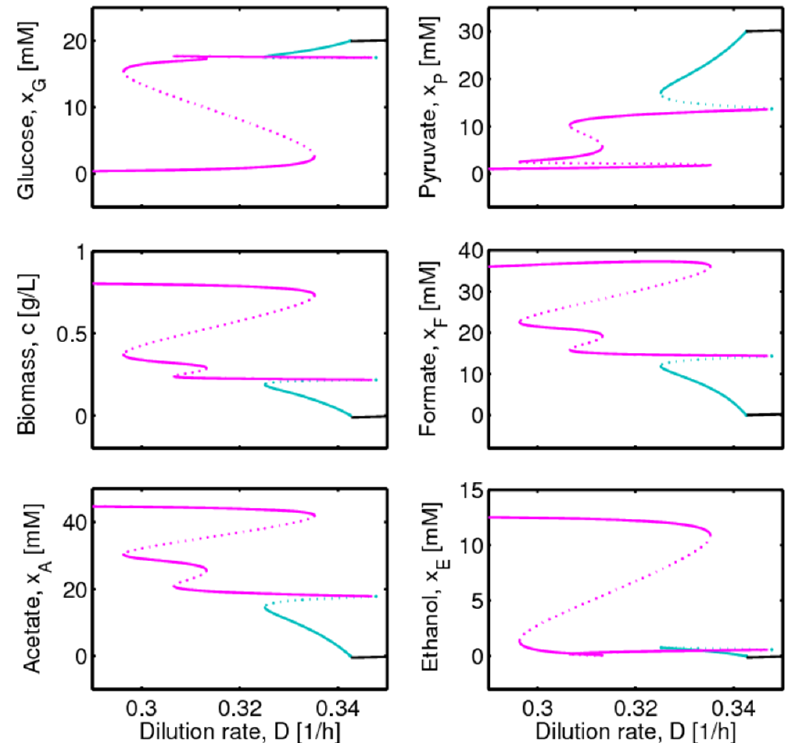
Figure 5. Hysteresis curves of all components when γ =